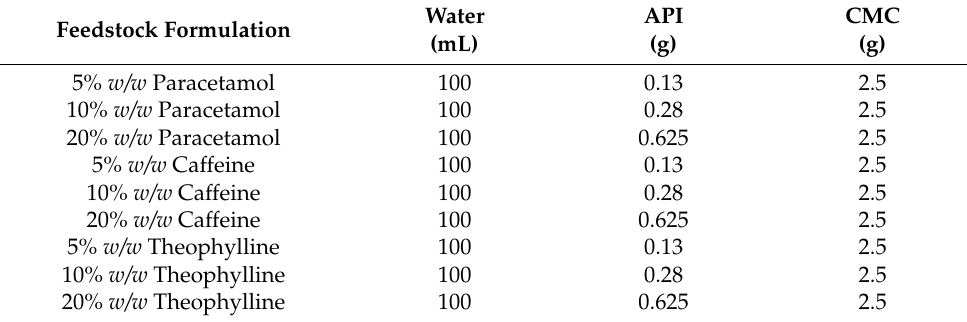
Table 1. Formulae for drug-loaded feedstock formulations. Feedstock Formulation